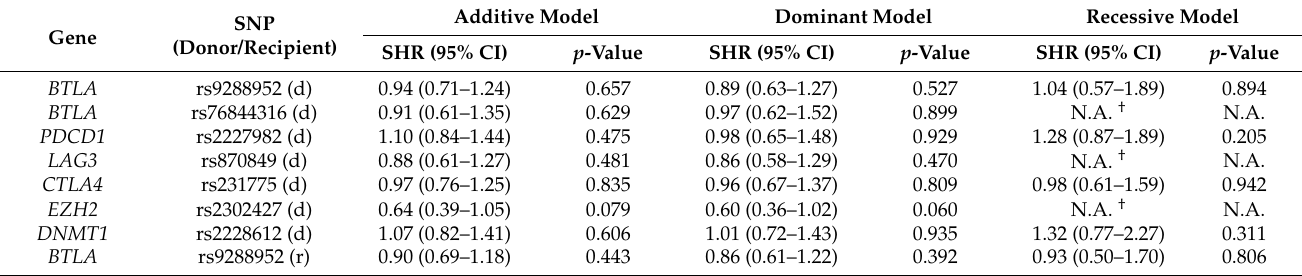
Table 3. Multivariable regression of extensive chronic GVHD on donor and recipient